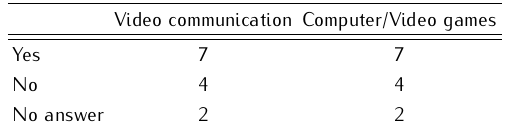
Table 1. The experience of video communication tools and/or computer/video gaming among the